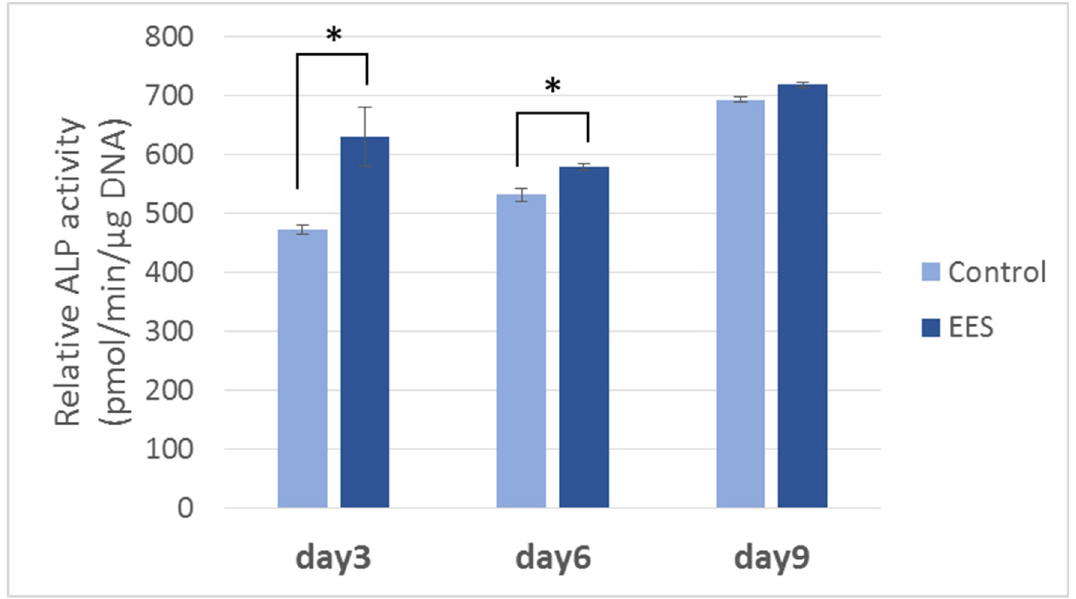
Fig 5. Effects of EES on the ALP activity of MC3T3-E1. Cells were subjected to EES for 2 days (Vd and Ie were fixed at 15.0 V and 1.2 μ A, respectively), and the ALP activities were examined at day 3, 6, and 9. The data points represent the mean value ± SD (n = 3), � p < 0.05 vs.